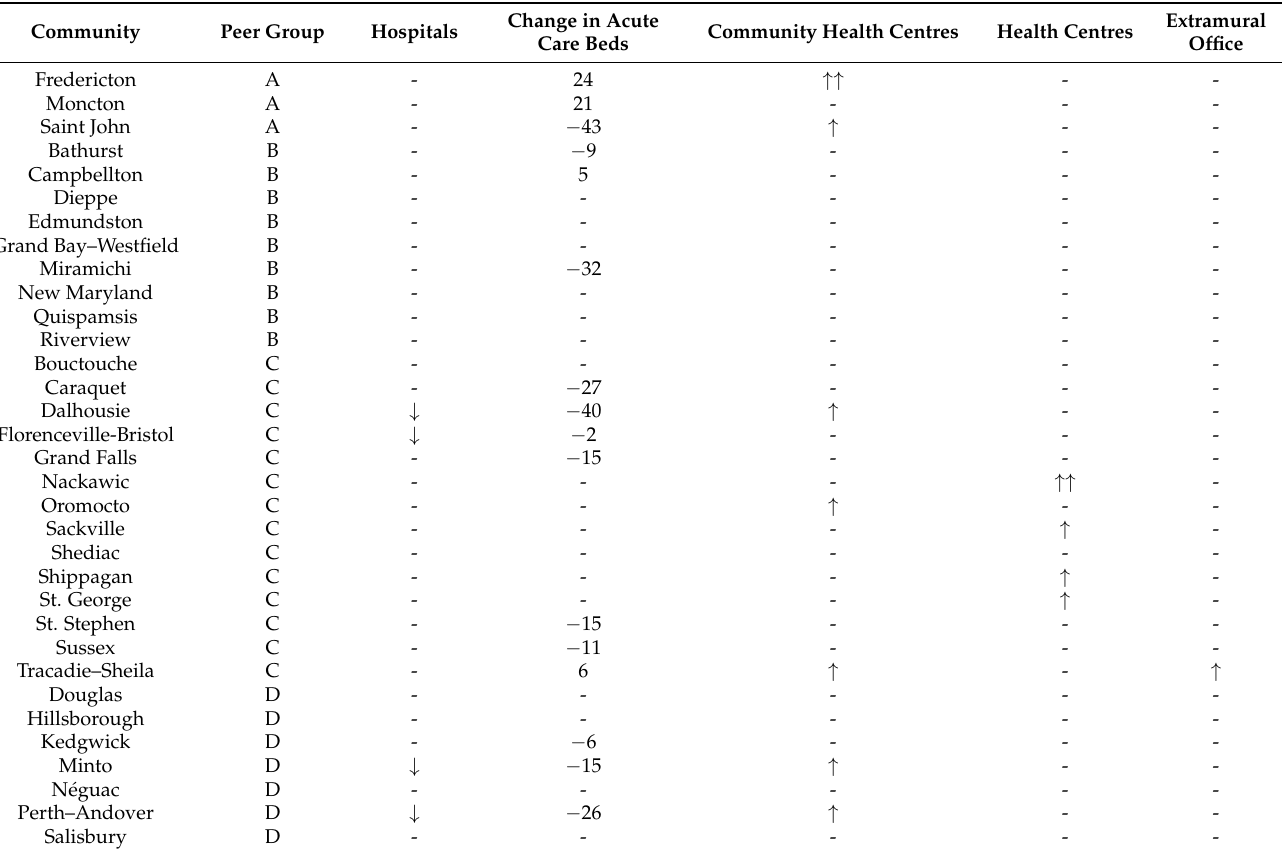
Table 2. Overview of 10-year differences in the provision of acute and primary care services per Health Council Communities: